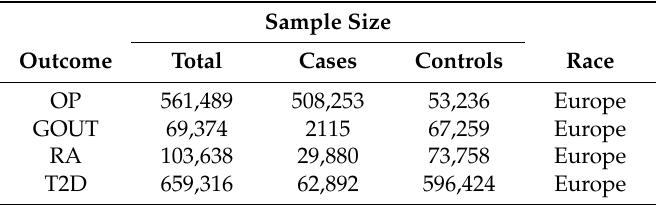
Table 2. Information on nine chronic